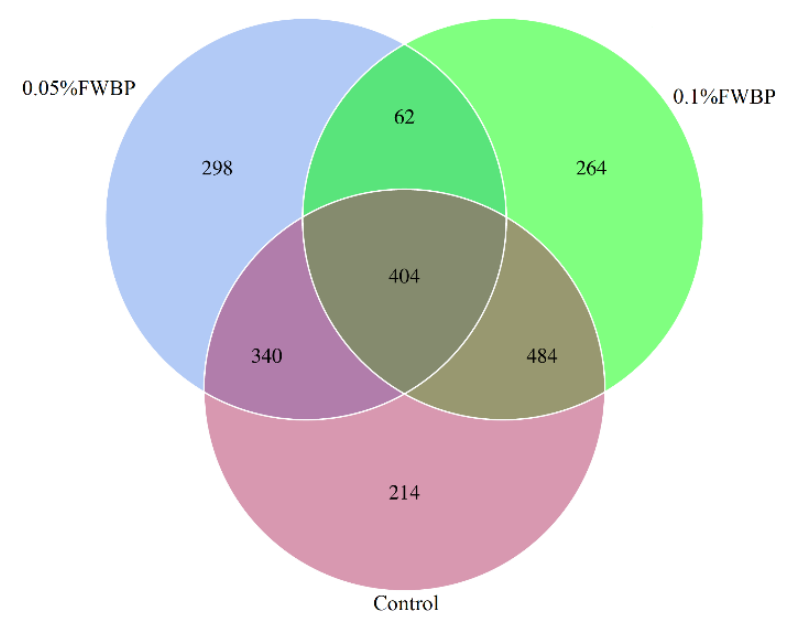
Figure 7. Venn diagram of OTUs among the dietary groups. FWBP: Fermented wheat bran